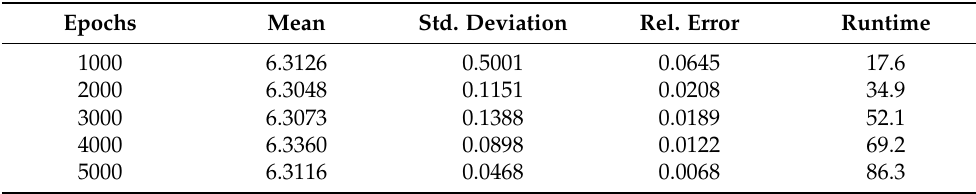
Table 2. Average value, standard deviation, average relative error of U 0 ( 0,110 ) and average run time for different number of epochs.